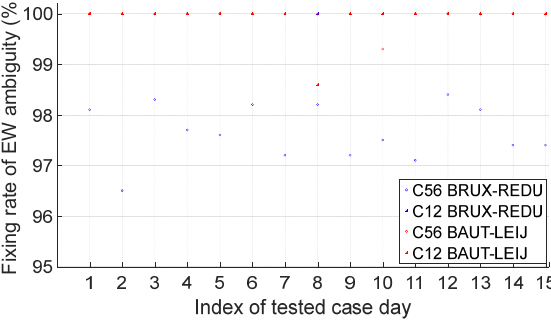
Figure 16. Fixing rate of Galileo extra ‐ wide ‐ lane ambiguity.